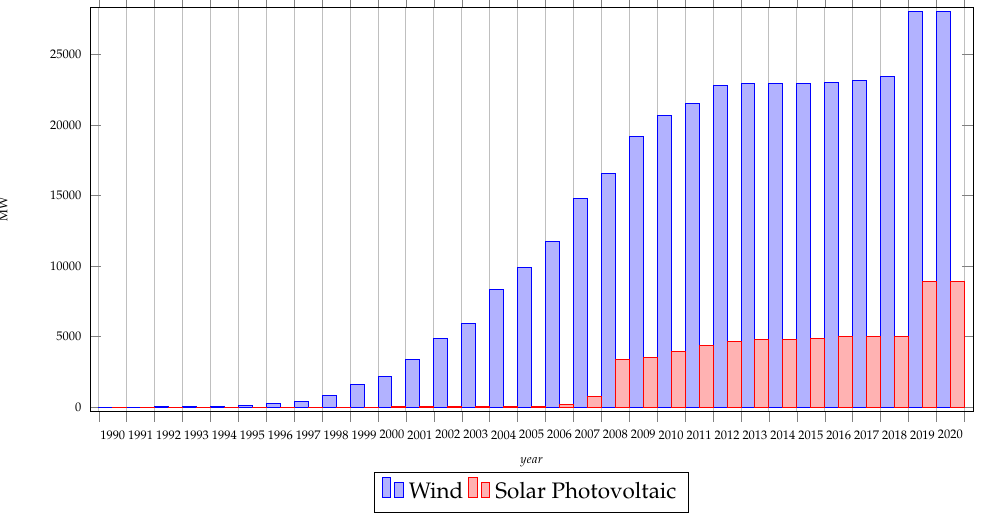
Figure 7. The installed capacity evolution of main renewable sources in Spain. Source: Red Eléctrica Española and Eurostat and draft forecast for 2019 and 2020 from Ferrero, J.